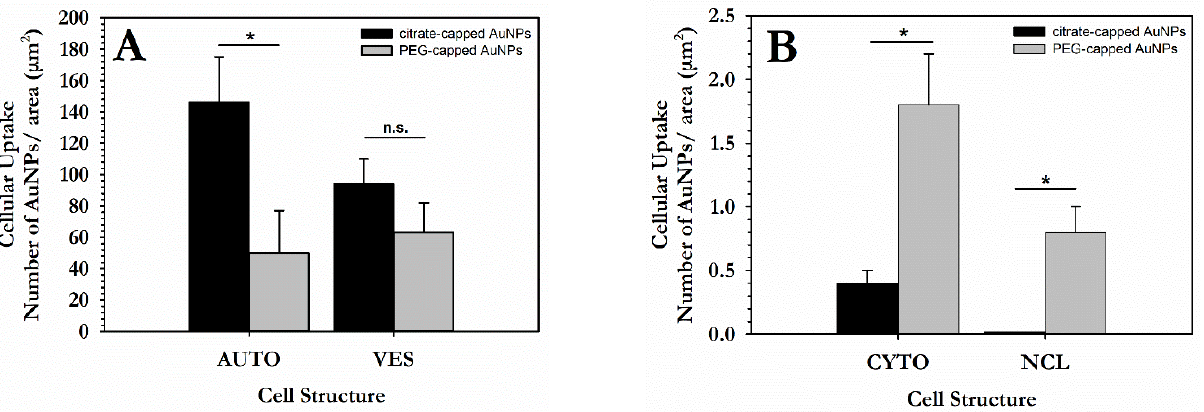
Figure 4. Quantification of gold nanoparticles’ (AuNPs) uptake in PC3 cells. Data are presented, in the form of histograms, as mean values of AuNPs/area in μ m 2 of different cellular compartments: ( A ) autophagosomes (AUTO), cytoplasmic vesicles (VES); ( B ) cytoplasmic area (CYTO) and nucleus (NCL). Figure shows the cellular uptake of both 15 nm Ct-capped AuNPs and PEG-capped AuNPs at 30 μ g/mL concentration. Statistical significance was determined using Student t test: * p ≤ 0.05, n.s.: not significant.